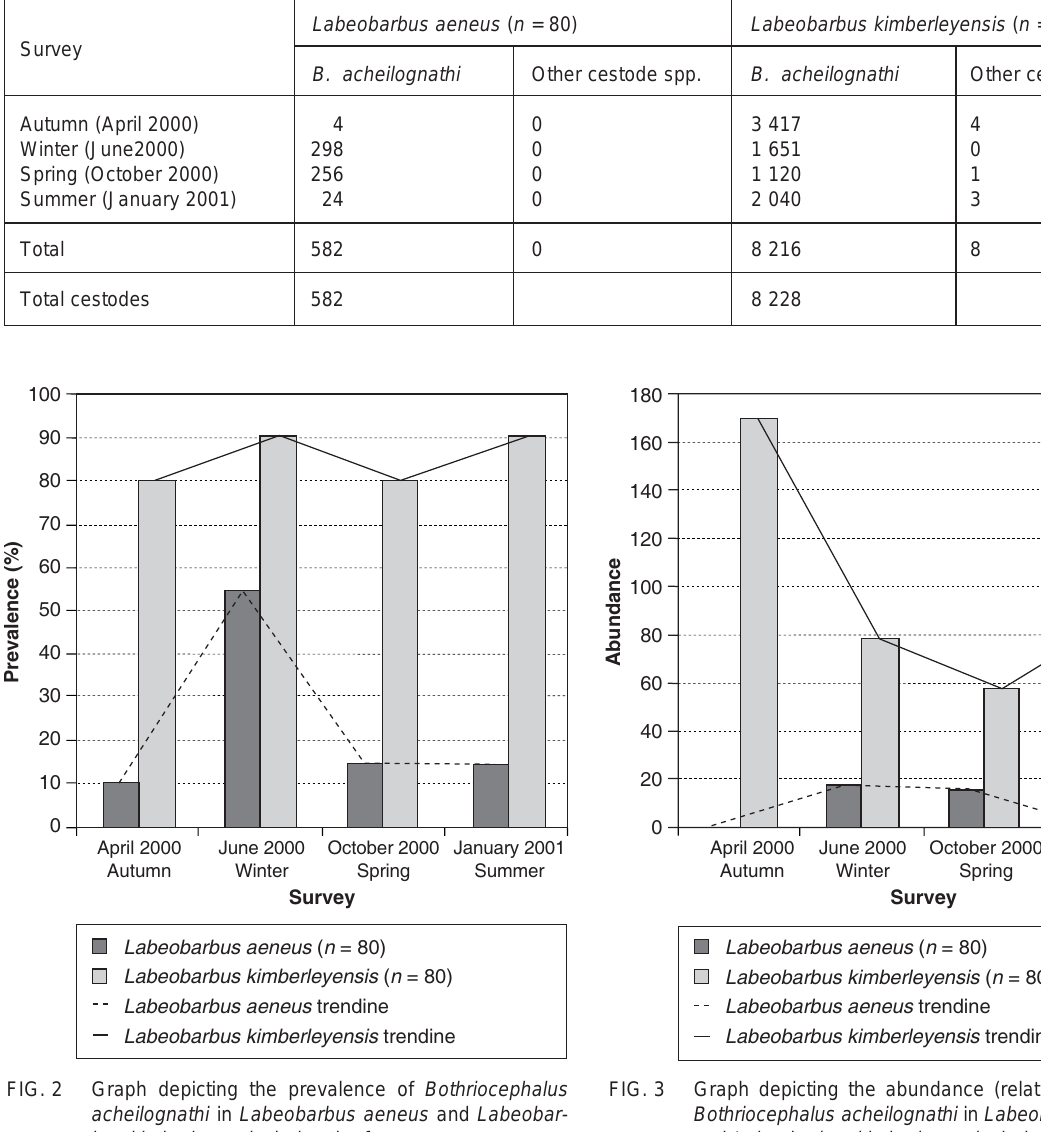
FIG. 2 Graph depicting the prevalence of Bothriocephalus acheilognathi in Labeobarbus aeneus and Labeobar- bus kimberleyensis during the four seasons